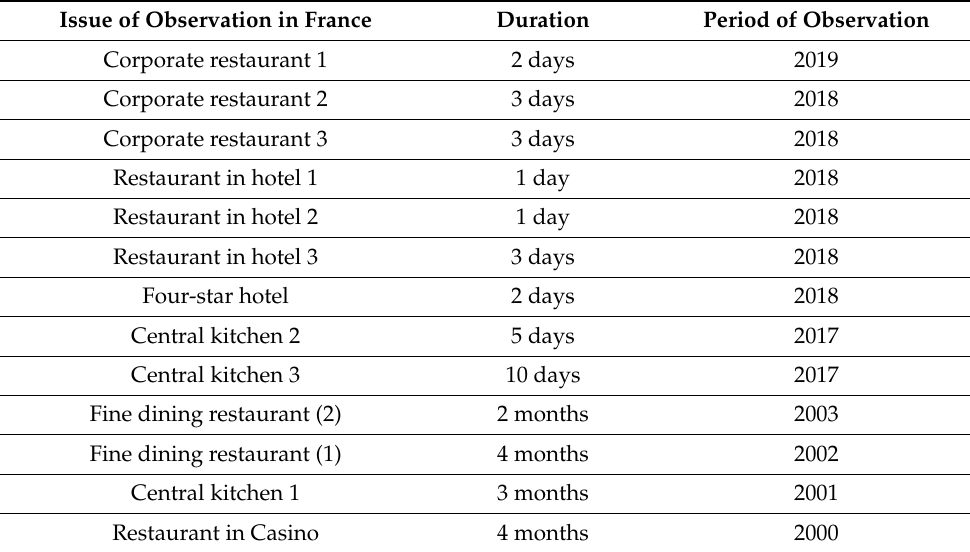
Table 1. List of restaurants and observation periods.